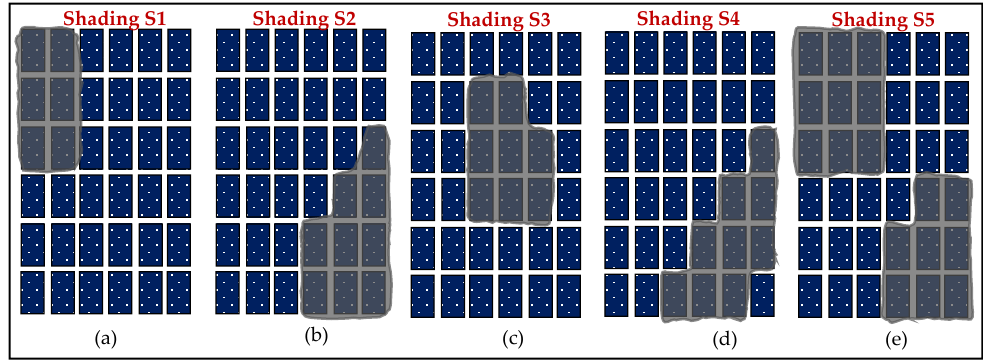
Figure 6. Partial shadings ( a ) S1, ( b ) S2, ( c ) S3, ( d ) S4, and ( e ) S5 for testing in PV arrays (based on actual cases).